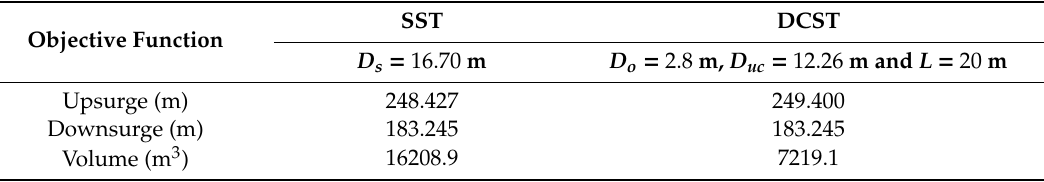
Figure 12. Piezometric head at the bottom tunnel of the surge tank and the water level in the surge tank before optimization (a) and after optimization (b).